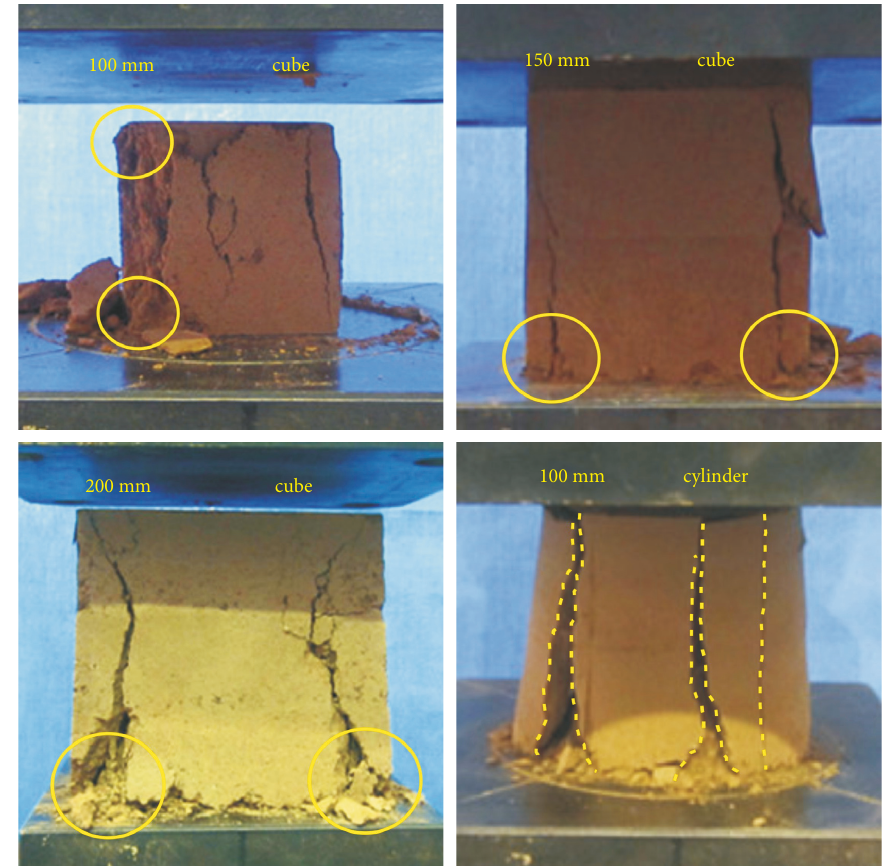
Figure 5: The failure patterns of